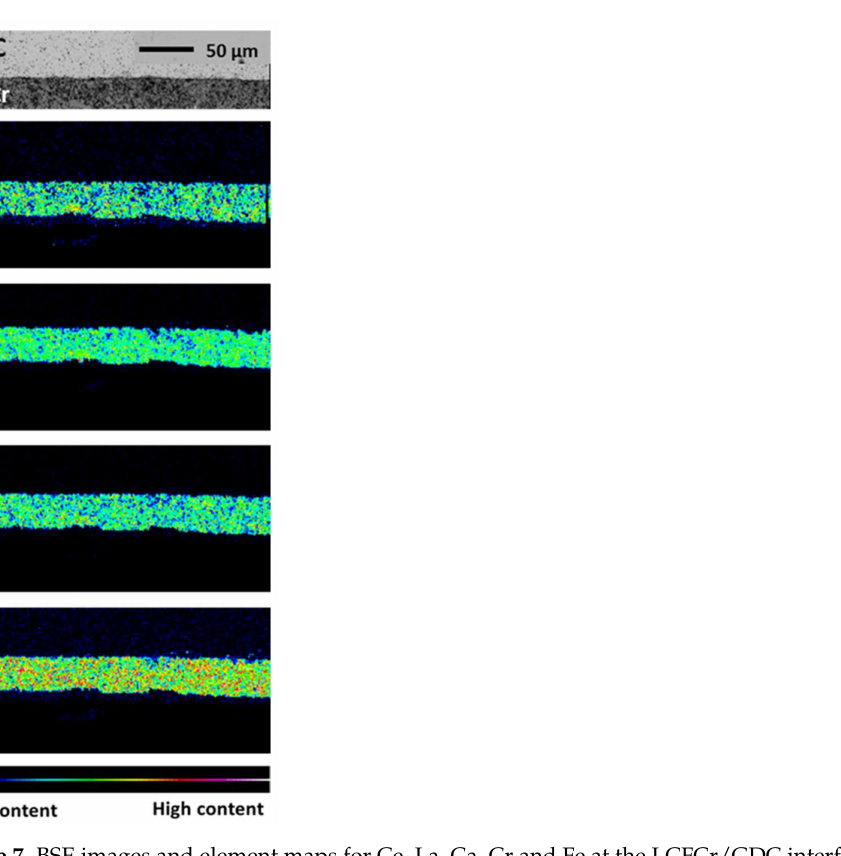
Figure 7. BSE images and element maps for Ce, La, Ca, Cr and Fe at the LCFCr/GDC interface after the electrochemical testing of an LCFCr WE at an overpotential of 0.2 and 0.65 V for 100 h each in air at 800 ◦